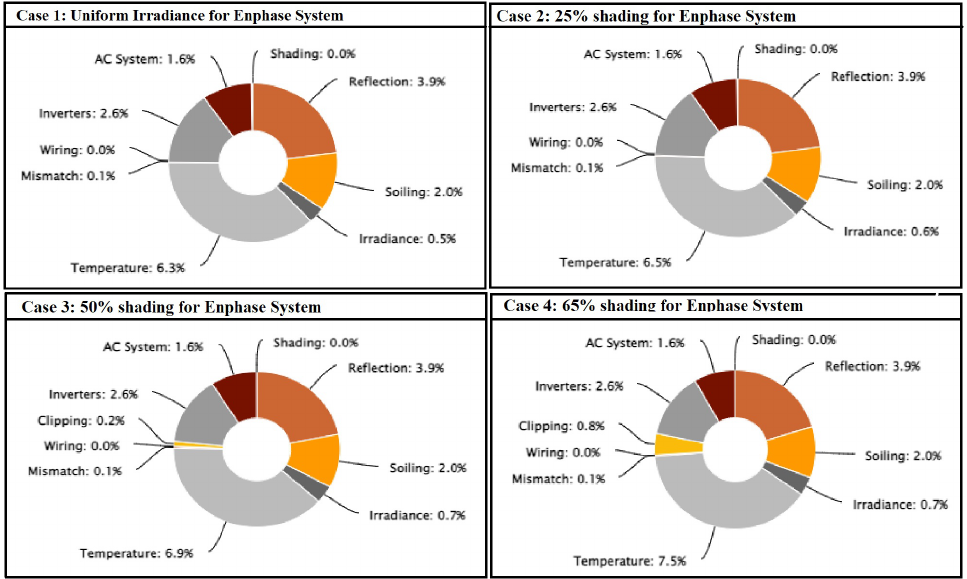
Figure 45. Results of various losses of Enphase inverter on different shading conditions using